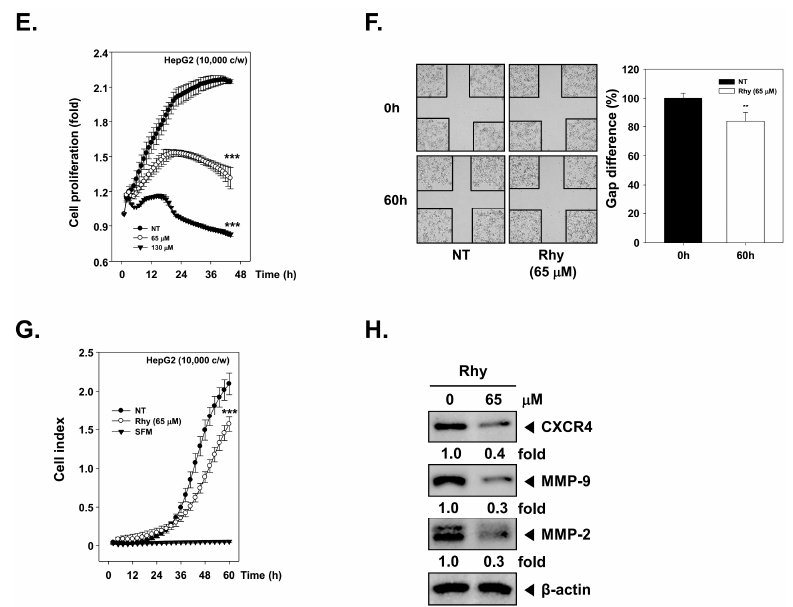
Figure 3. Apoptotic and anti-metastatic effect of Rhy in HepG2 cells. ( A ) After HepG2 cells (1 × 10 6 cells/well) were seeded onto six-well plates, they were treated with 130 µ M of Rhy for 36 h. Then, the cells were harvested, washed with a cold PBS buffer, and digested with RNase. Cellular DNA staining with PI and flow cytometric analysis was done to determine the cell cycle distribution as described in the Materials and Methods; ( B ) HepG2 cells (1 × 10 6 cells/well) were treated with Rhy for 48 h. The cells were incubated with an FITC-conjugated Annexin V antibody and then analyzed by a flow cytometry as described in Materials and Methods. Data are representative of the best quality data collected from three individual experiments with similar results and the percentage of late apoptotic cells (upper right quadrant); ( C ) After HepG2 cells (1 × 10 6 cells/well) were seeded onto six-well plates, they were treated with 130 µM of Rhy for 48 h. The cells were fixed and incubated using TUNEL reaction solution and then analyzed by a flow cytometry. Data are representative of the best quality data collected from three individual experiments with similar results; ( D ) HepG2 cells were treated with Rhy (130 µM) for 36 h. Cells were stained with a live/dead assay reagent for 30 min and then analyzed under a fluorescence microscope (40×) as described in Materials and Methods. Percentage of apoptosis is indicated in the inset; ( E ) HepG2 cells were plated in triplicate and treated with Rhy (65 or 130 µM), then cell proliferation was measured by real time cell analysis (RTCA). Values represent the mean ± SD of triplicate cultures (*** p <0.001); ( F ) Wound healing assay was performed for evaluating the inhibitory effect of Rhy on HepG2 cells migration. Confluent monolayers of HepG2 cells were scarred, and repair was monitored microscopically after 60 h of treatment with 65 µM Rhy. Width of wound was measured at time 0 and 60 h of incubation with and without Rhy. Values represent the mean ± SD of triplicate cultures (** p < 0.01); ( G ) Invasion assay was performed using the Roche xCELLigence Real-Time Cell Analyzer (RTCA) DP instrument (Roche Diagnostics GmbH, Mannheim, Germany) as described in Materials and Methods. We tested HepG2 cells invasion activity (40,000 cells/well) in the matrigel-coated CIM (cellular invasion/migration)-Plate 16 with Rhy (65 µM); ( H ) Rhy downregulated expression of CXCR4 and MMP-9/2. HepG2 cells (1 × 10 6 cells/well) were incubated with Rhy (65 µM) for 60 h. Whole-cell extracts were prepared, and 20 µg of the whole-cell lysate was resolved by sodium dodecyl sulfate polyacrylamide gel electrophoresis (SDS-PAGE), electrotransferred to nitrocellulose membrane, sliced from the membrane based on the molecular weight, and then probed with antibodies against CXCR4, MMP-9, and MMP-2 as described in Materials and Methods. The same blots were stripped and reprobed with β -actin antibody to verify equal protein loading. FL2-A, gating for single cells based on the area; FL1-H, relative intensity of GFP florescence; NT, Non treat.